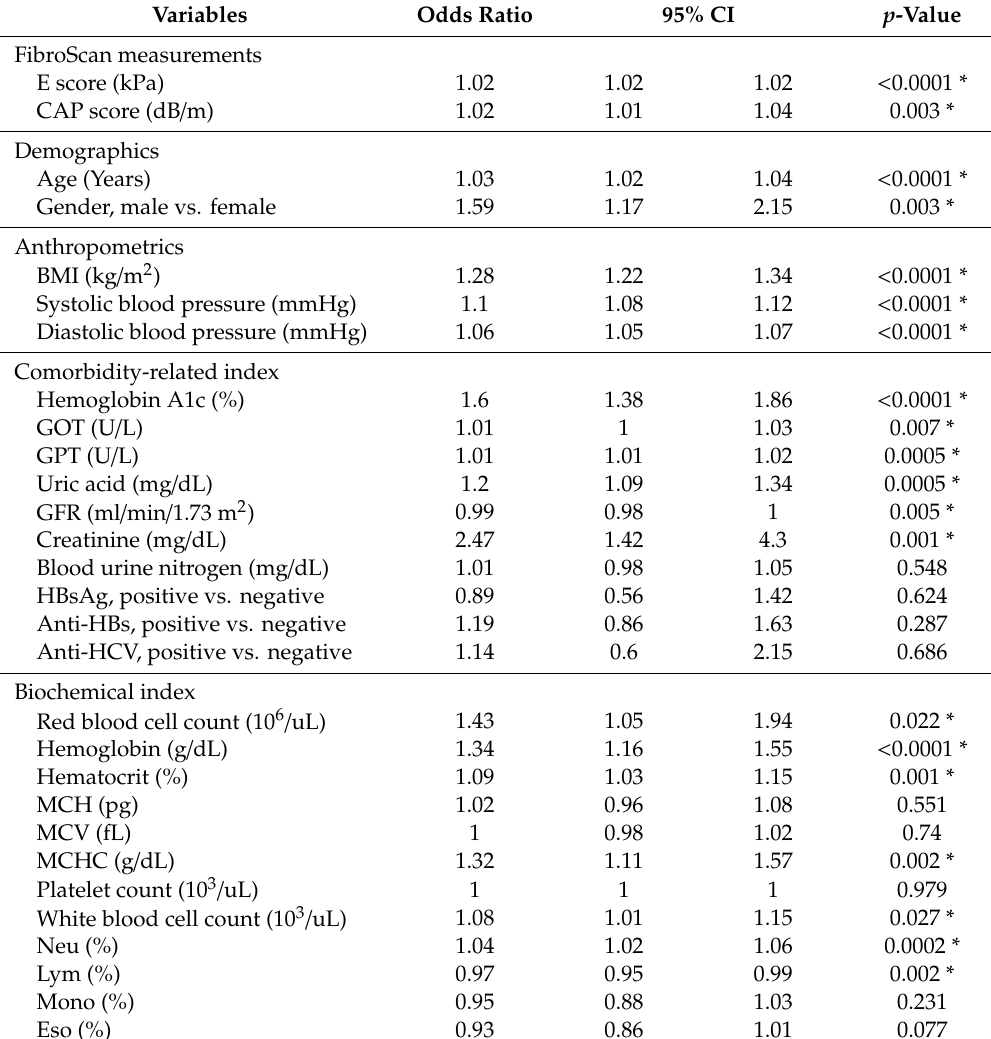
Table 2. Univariate logistic regression analysis for the presence of metabolic